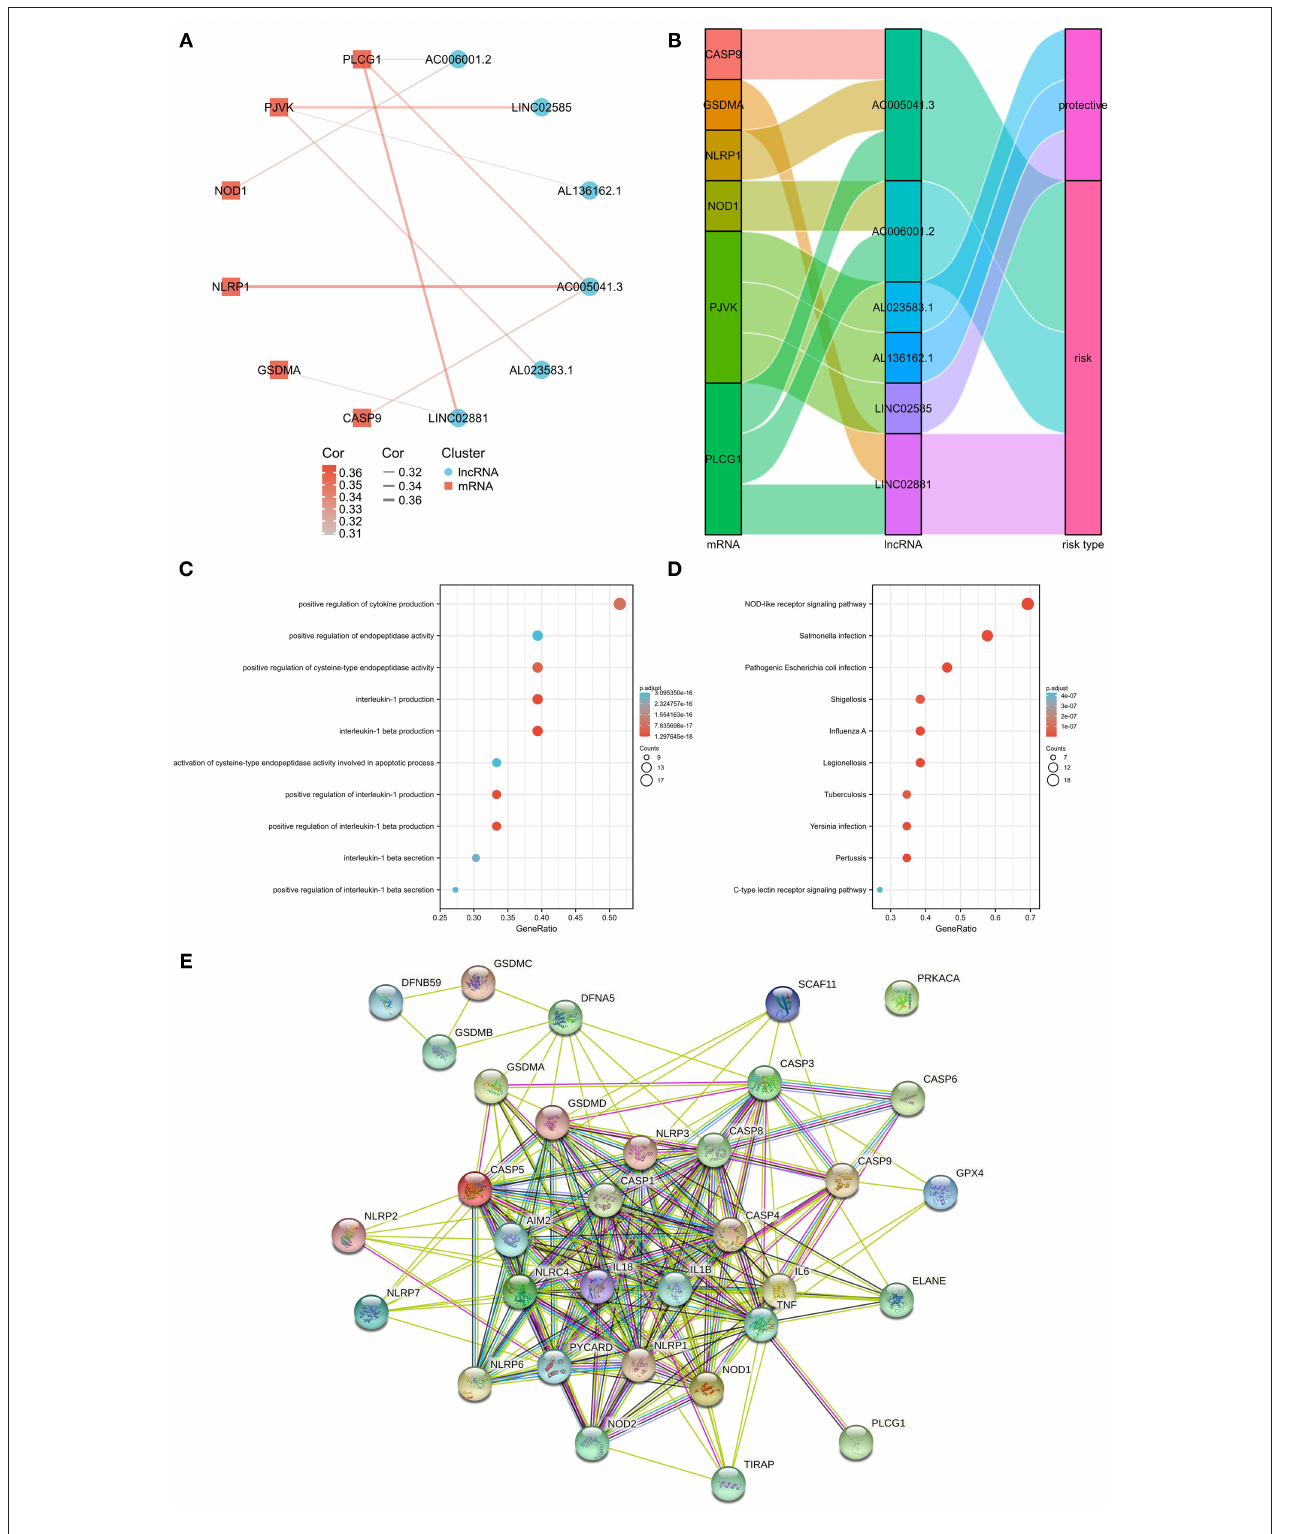
FIGURE 2 | The messenger RNA (mRNA)-lncRNA co-expression network. (A) mRNA-lncRNA co-expression network of the pyroptosis-related genes and selected pyroptosis-related lncRNAs. (B) Sankey diagram showing the connection degree between the pyroptosis-related lncRNAs and the pyroptosis-related genes. (C) Gene Ontology (GO) analysis of 33 pyroptosis-related genes. (D) Kyoto Encyclopedia of Genes and Genomes (KEGG) analysis of 33 pyroptosis-related genes. (E) PPI chart of 33 pyroptosis-related genes.